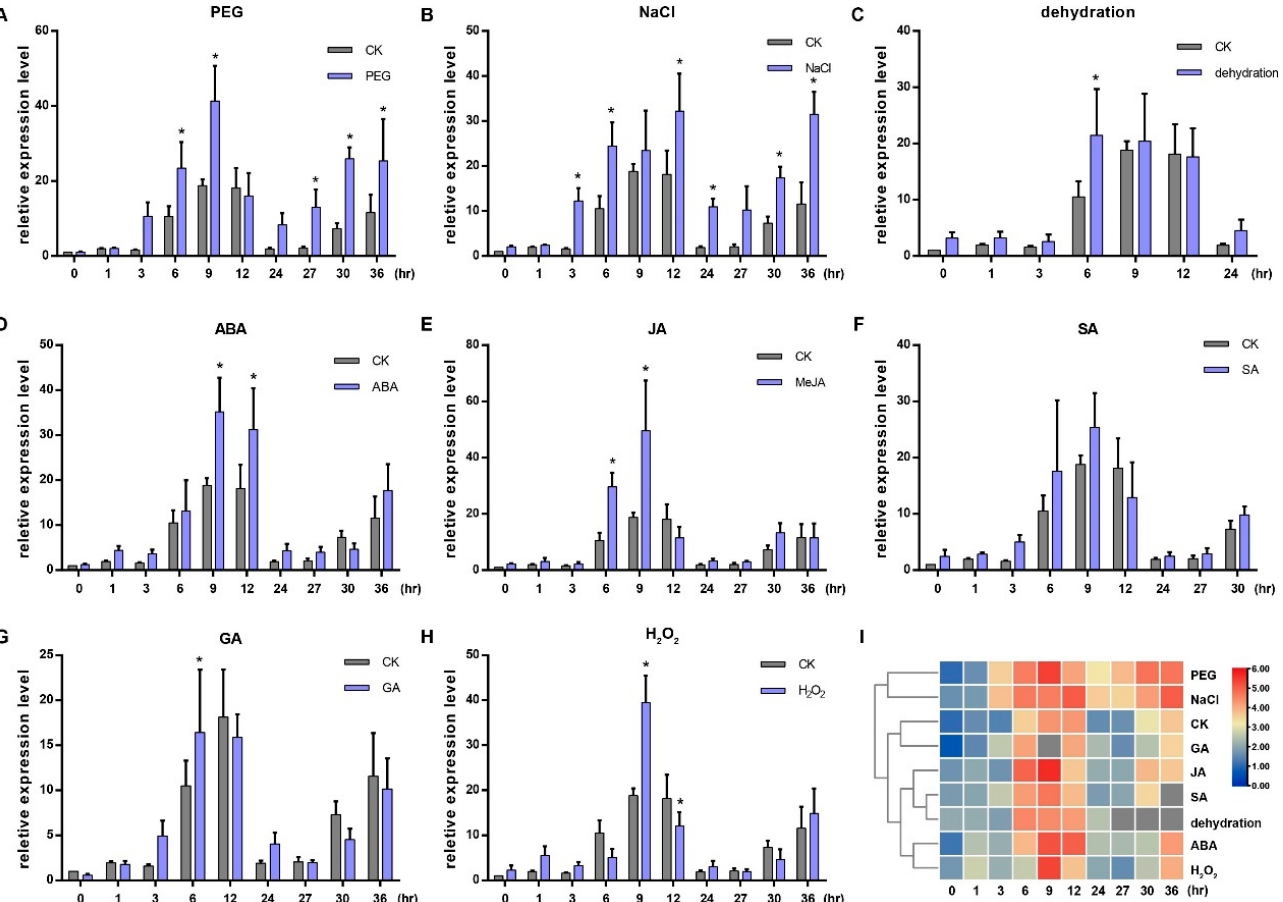
Figure 2. Expressions of OsGRP3 responding to PEG 6000 ( A ), NaCl ( B ), dehydration ( C ), ABA ( D ), JA ( E ), SA ( F ), GA ( G ) and H 2 O 2 ( H ). CK indicates control. All the relative expression values of OsGRP3 under different treatments at different times were calculated compared with the expression value of CK at 0 h, which was normalized to 1. The significant differences were determined using the Student’s t -test, * p < 0.05. The horizontal axis shows the processing time. ( I ) Cluster analysis of the expressions of OsGRP3 responding to different treatments.